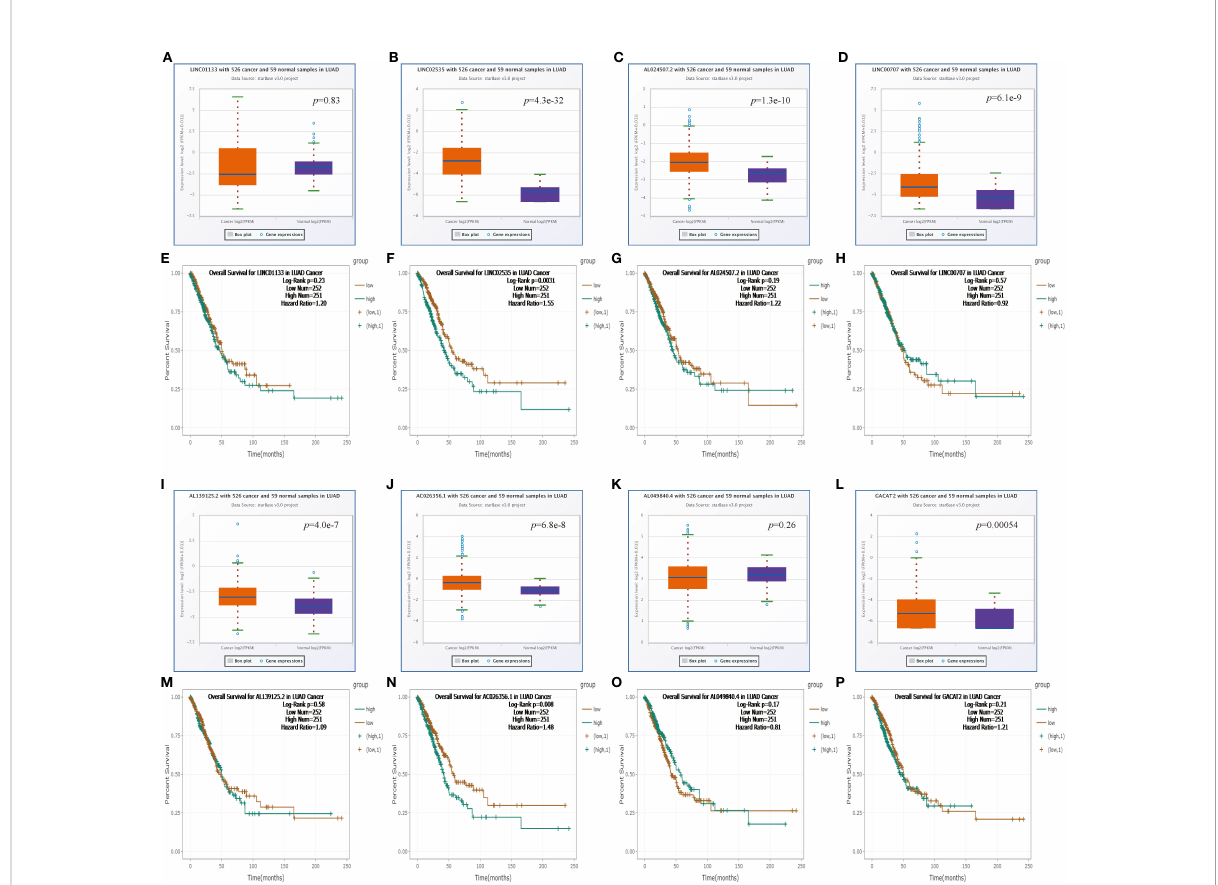
FIGURE 5 Expression analysis and survival analysis for upstream lncRNAs of miR-30d-5p in LUAD (A – D, I – L) . The expression of LINC01133 (A) , LINC02535 (B) , AL024507.2 (C) , LINC00707 (D) , AL139125.2 (I) , AC026356.1 (J) , AL049840.4 (K) , and GACAT2 (L) in the starBase database. (E – H, M – P) The